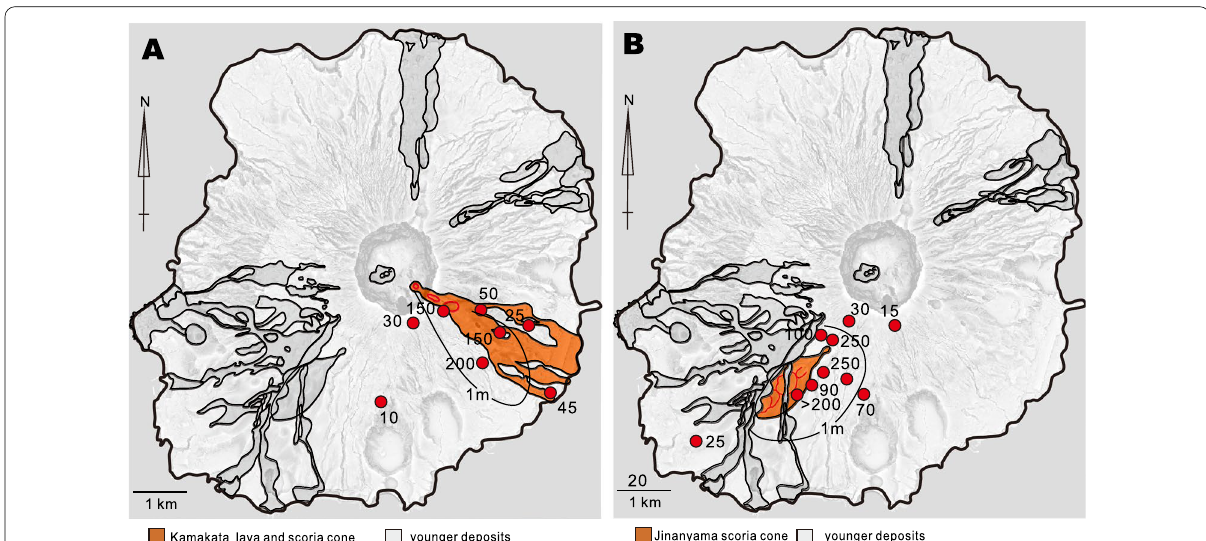
Fig. 8 Distributions of the deposits of Kamakata eruption ( A ) and Jinanyama eruption ( B ), which occurred in the sixteenth century. Red circles show the measurement points of thickness of the scoria fall deposit of each eruption. Gray areas show the distribution of the deposits younger than the